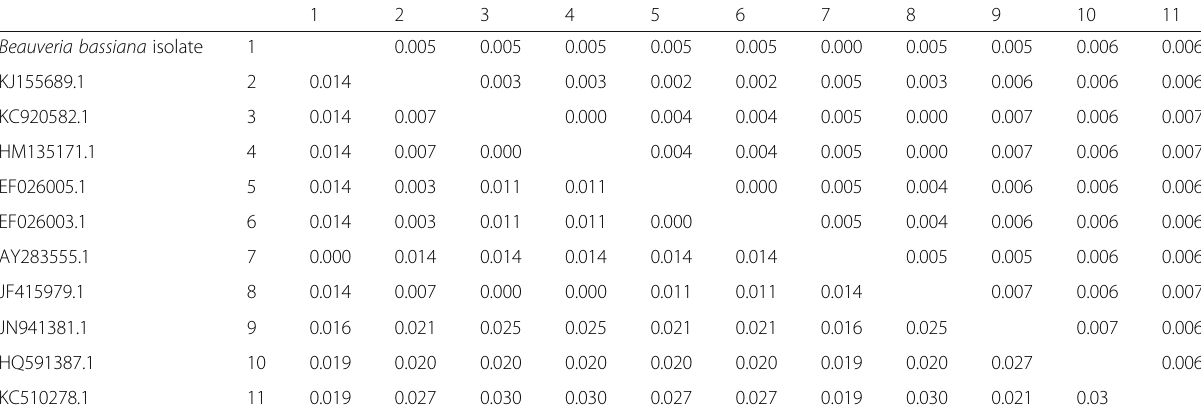
Table 2 Distance matrix, among selected fungal strains, based on the nucleotide substitutions in the sequence spanning D2 domain of 28S rDNA D2